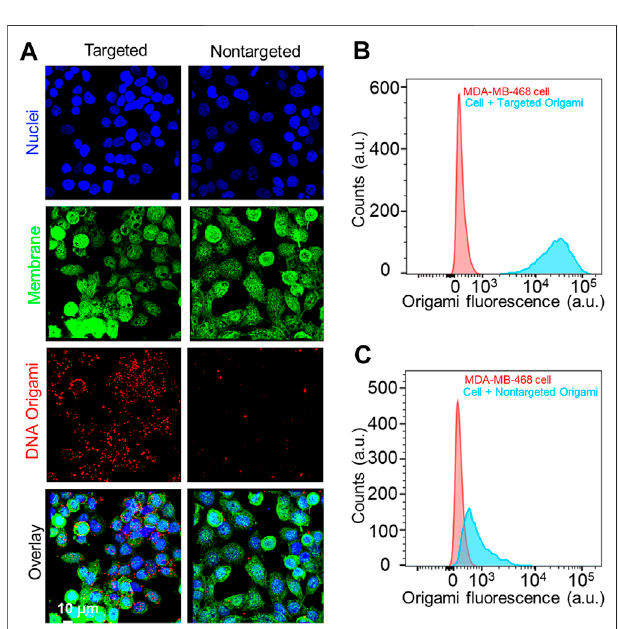
FIGURE3| (A) Fluorescence microscope images ofMDA-MB-468 cells incubated with 10pM of targeted and nontargeted DNA origami structures for12 h. The red signal from DNA origami clearly showed a higher uptake of the targeted origami. Cell nucleus and membrane was stained with Hoechst ® 33342 (blue) and wheat germ agglutinin, AF488 conjugate (green), respectively. (B, C) Flow cytometry-based analysis also re fl ected the same trend,enhanceduptakeoftargetedorigamicomparedtonontargetedorigami to the MDA-MB-468 cells.